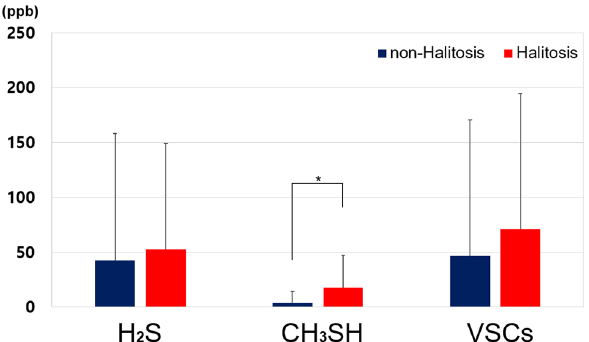
Figure 1. Comparison of H 2 S, CH 3 SH, and total VSCs between non-halitosis and halitosis groups.